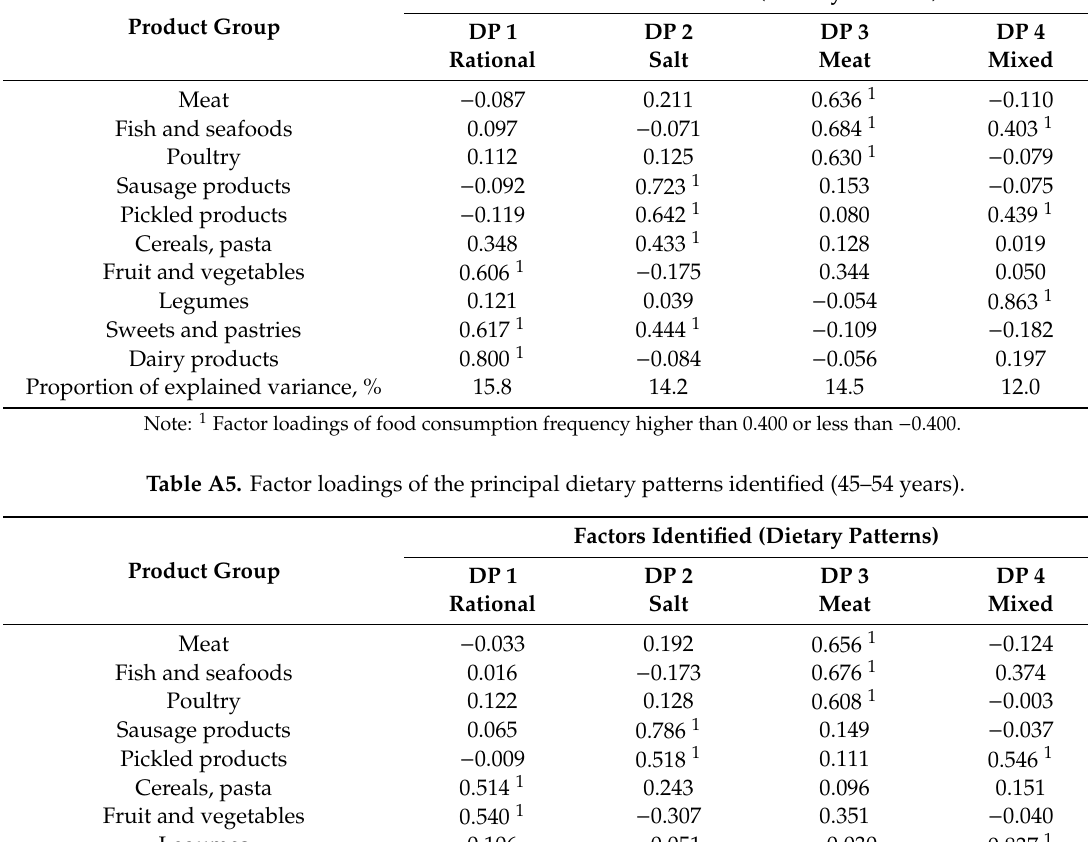
Table A4. Factor loadings of the principal dietary patterns identified (35–44 years).